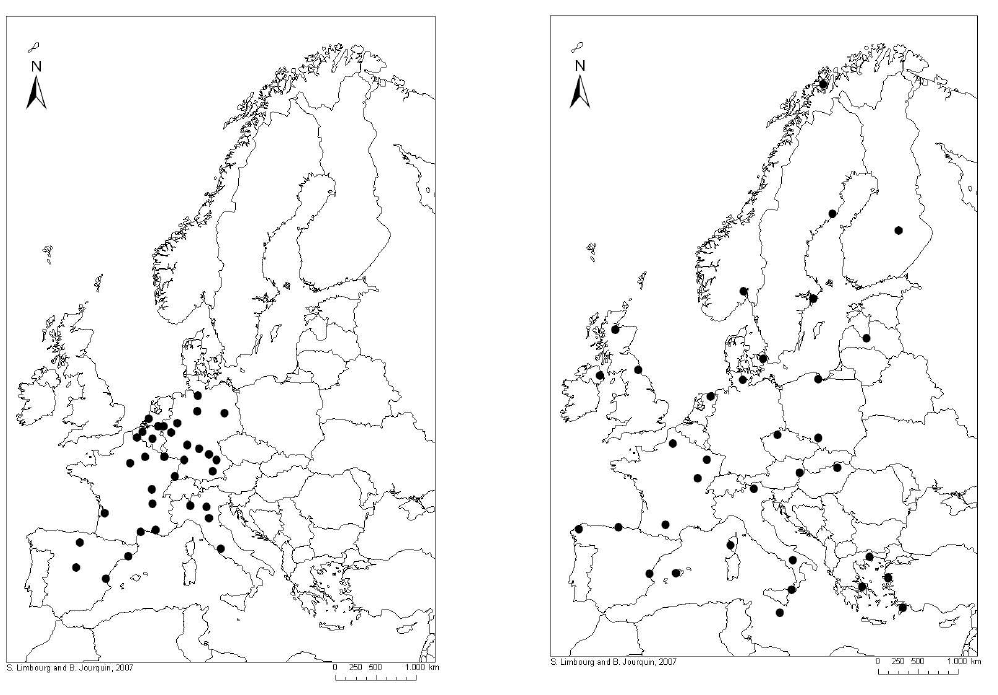
Figure 11. Set of selected potential locations Figure 12. Ward aggregated